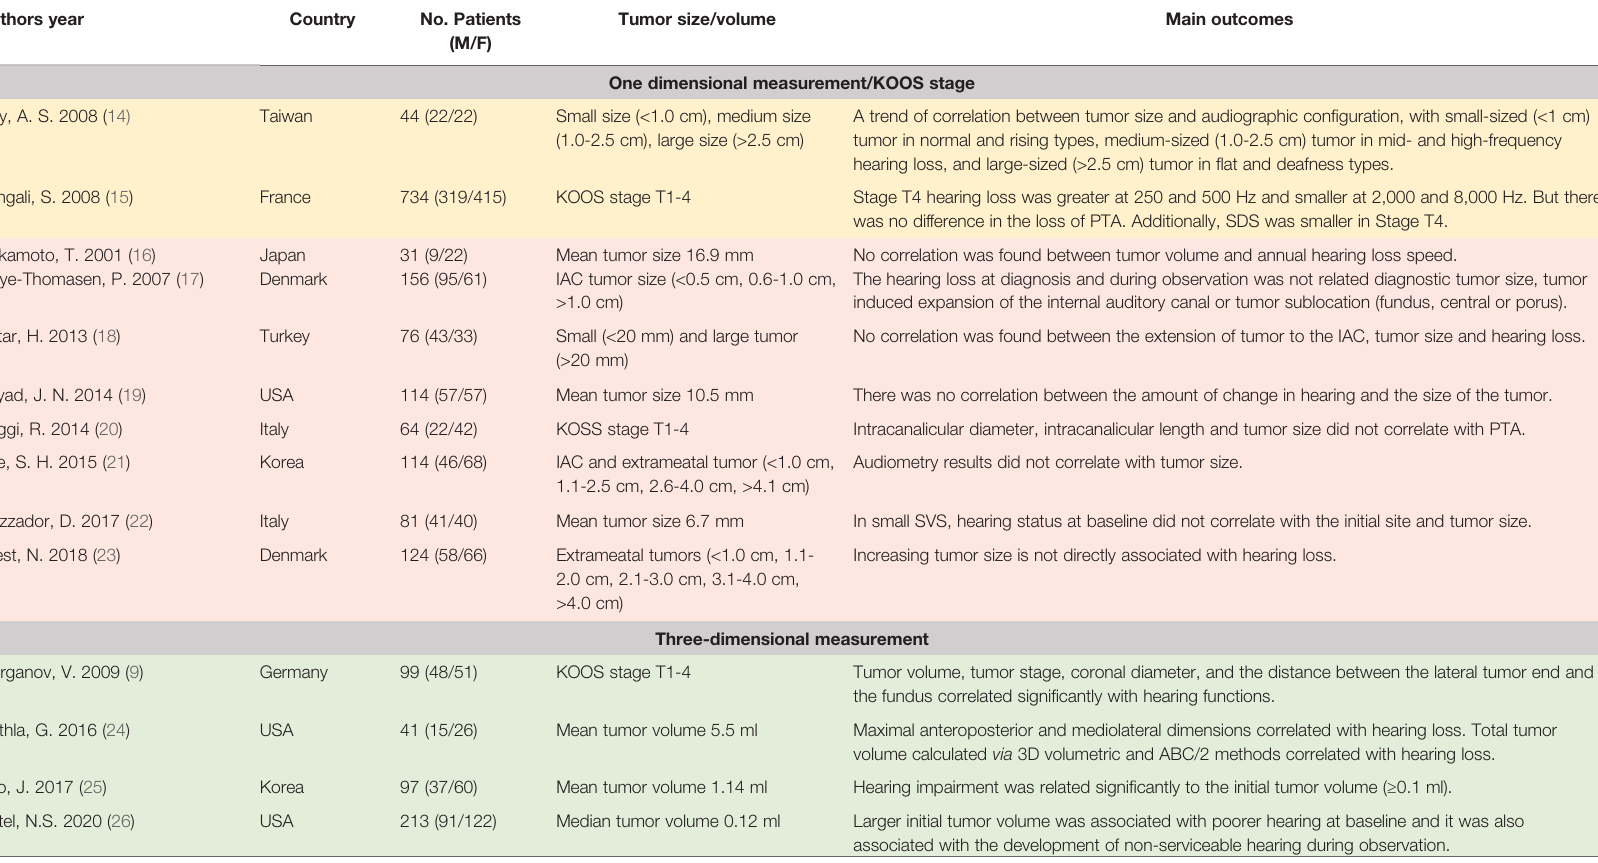
TABLE 1 | The summarization of literature regarding the association between tumor size/volume of SVS and hearing loss. Authors